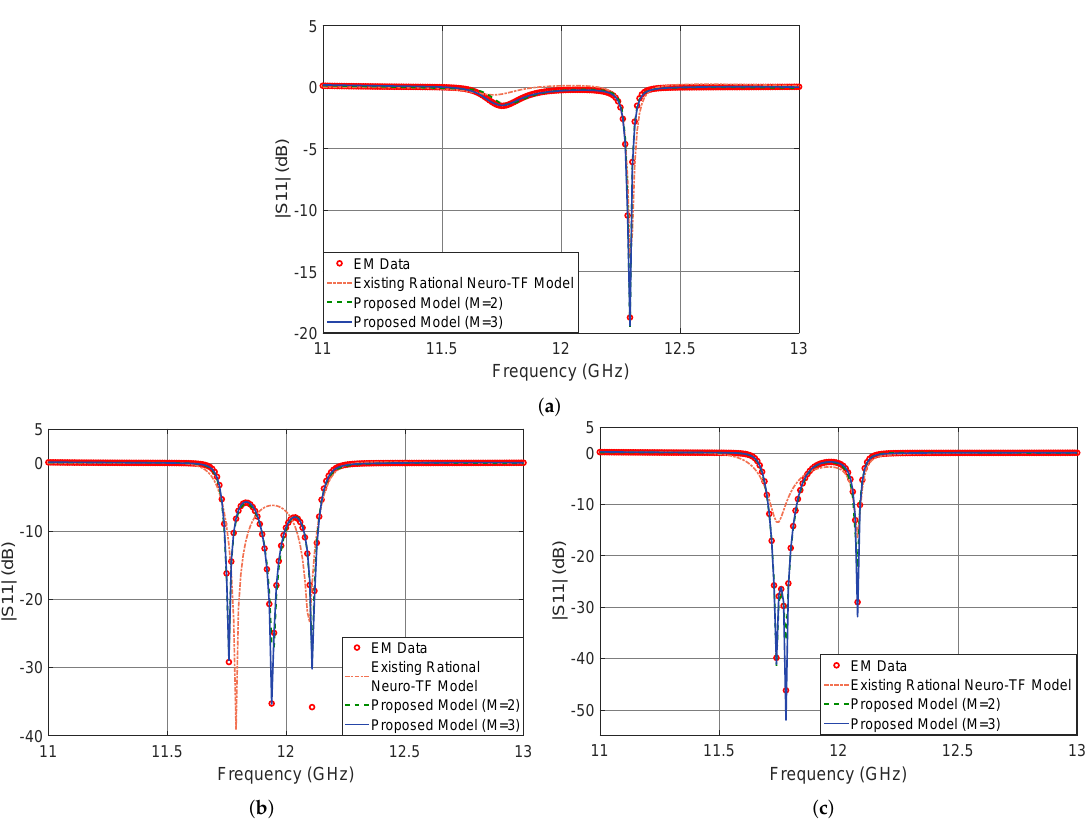
Figure 5. Comparison of magnitude in decibels of S 11 different modeling approaches and EM data: ( a ) test sample x = [ 14.37 14.57 9.25 6.17 ] T (mm), ( b ) test sample x = [ 14.17 15.20 8.75 6.25 ] T (mm), and ( c ) test sample x = [ 14.56 15.20 8.63 6.17 ] T (mm) for the three-order waveguide filter